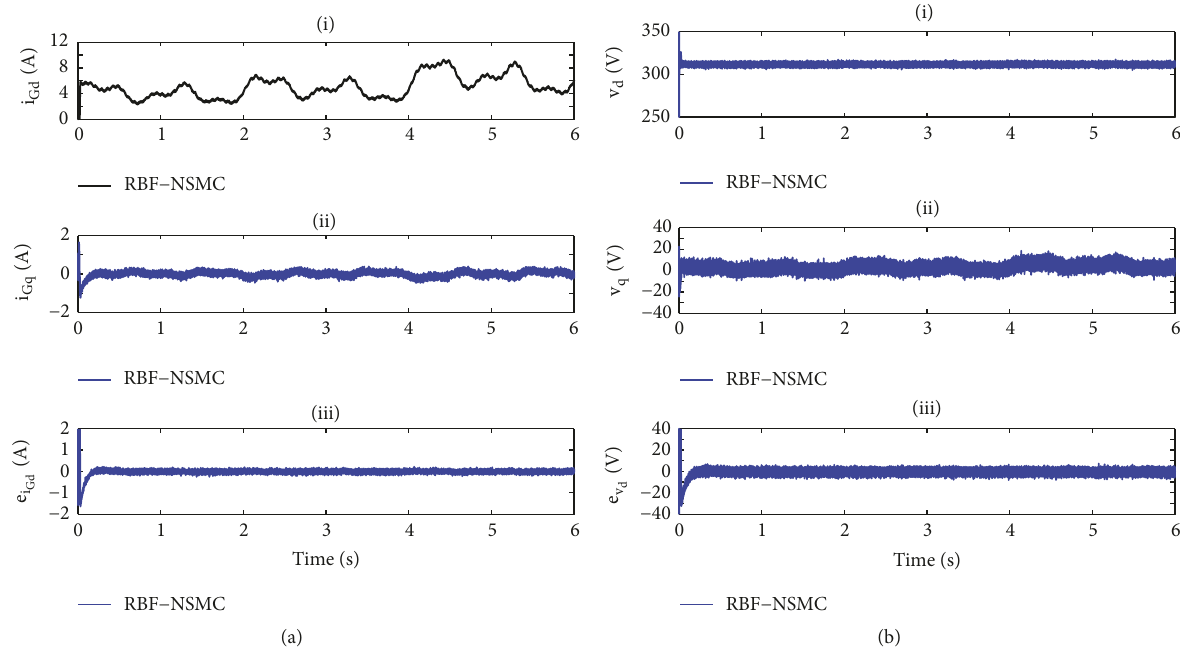
Figure 8: Control system response to wind speed fluctuations with nominal values of parameters. (a) (i) Grid 𝑑− axis current, (ii) grid q-axis current, and (iii) grid 𝑑− axis current error. (b) (i) 𝑑− axis voltage across LCL filter capacitor, (ii) 𝑑− axis voltage across LCL filter capacitor, and (iii) error signal of 𝑑− axis voltage across LCL filter